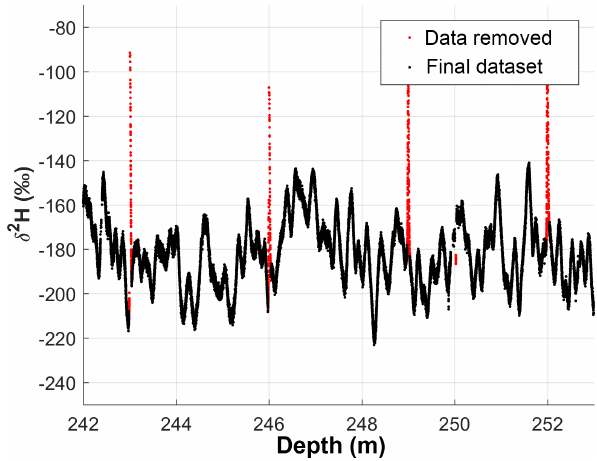
Figure 2. A selected example section of δ 2 H vs. depth. The data marked in red represent the transitions between the Milli Q standard and ice core at the boundaries of each 3m stack. These data points (and other poor quality data) were removed from the final data set.